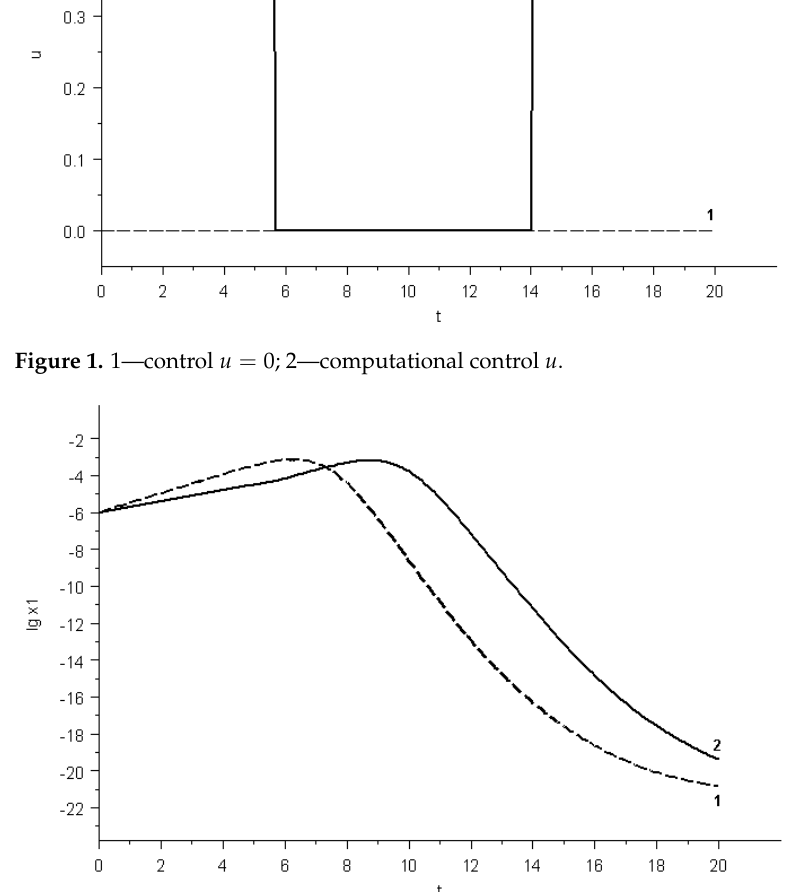
Figure 2. 1—trajectory lg x 1 for u = 0; 2—computational trajectory lg x 1